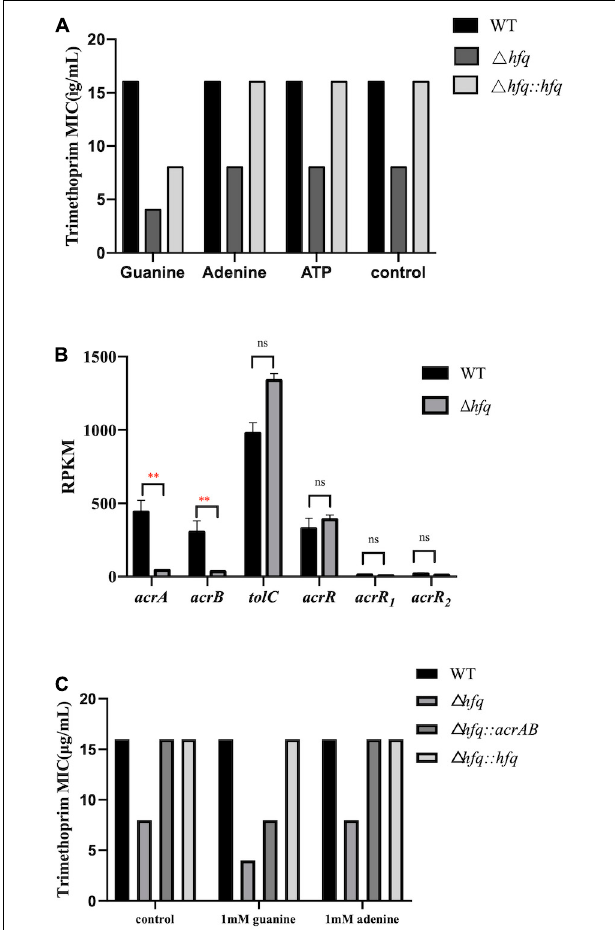
FIGURE 6 | MIC of trimethoprim under conditions of exogenous purine metabolites and overexpressed AcrAB. (A) The concentrations of exogenous products are 1 mM for adenosine, guanosine, and adenosine triphosphate, and ATP. Equal volume of ddH 2 O was added as a control group (B) . Expression of key genes in the efflux pump. The rpkm of three acrR copies was presented separately. (C) MIC of trimethoprim to Aeromonas veronii overexpressing acrAB . ∗ represents p < 0.05, ∗∗ represents p < 0.01, and ns represents no significant